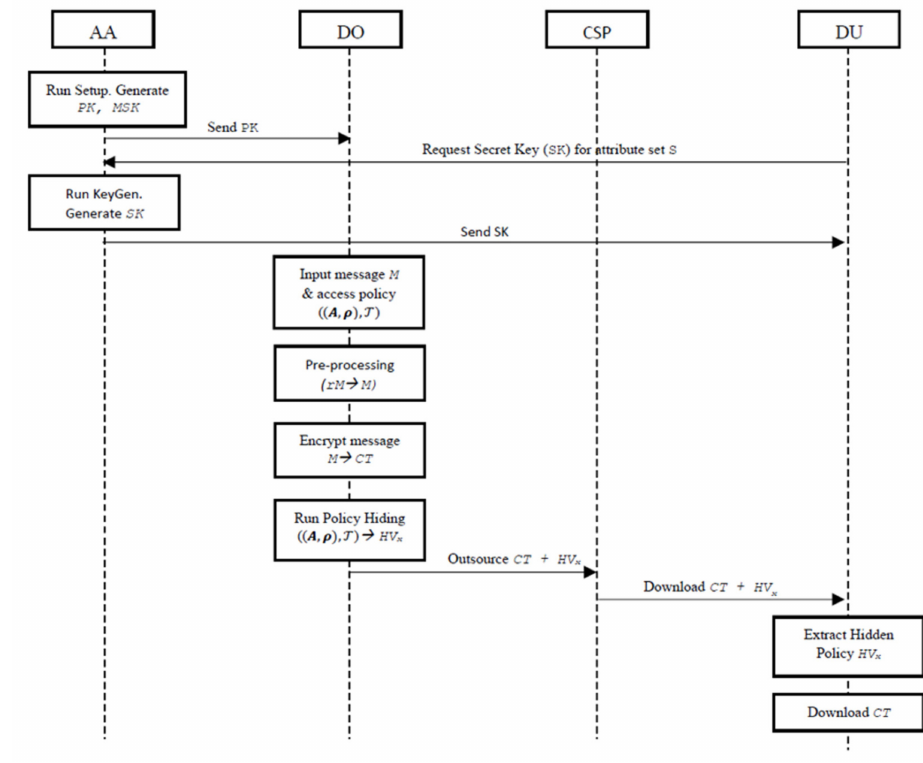
Figure 3. Process sequence chart of the proposed CP-ABE